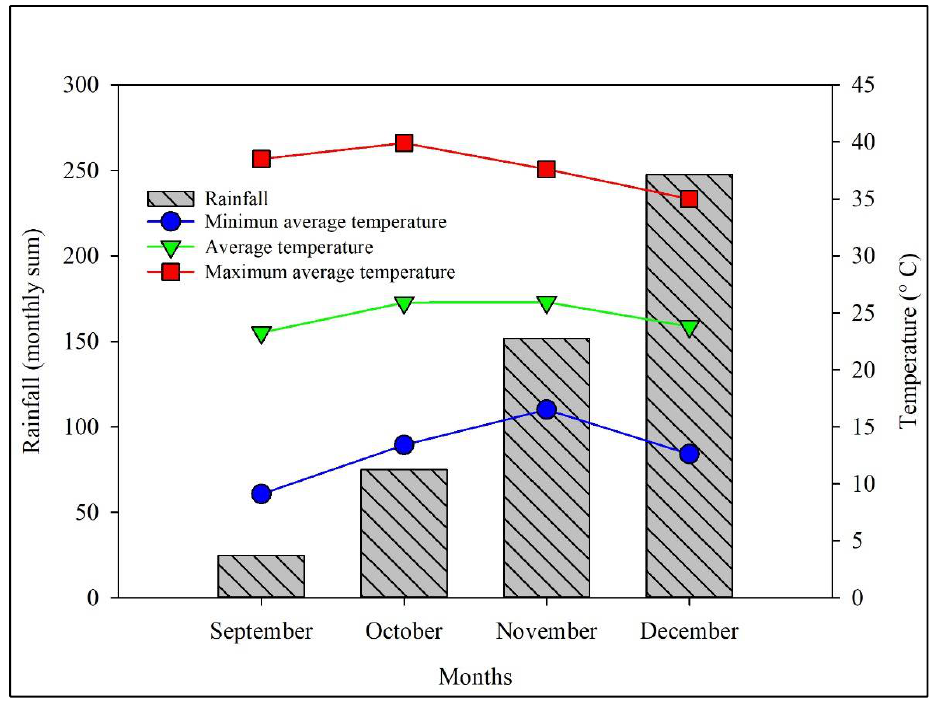
Figure 2. Seasonal variation of maximum/minimum/average temperature, monthly accumulated rainfalls recorded from October to December 2019.